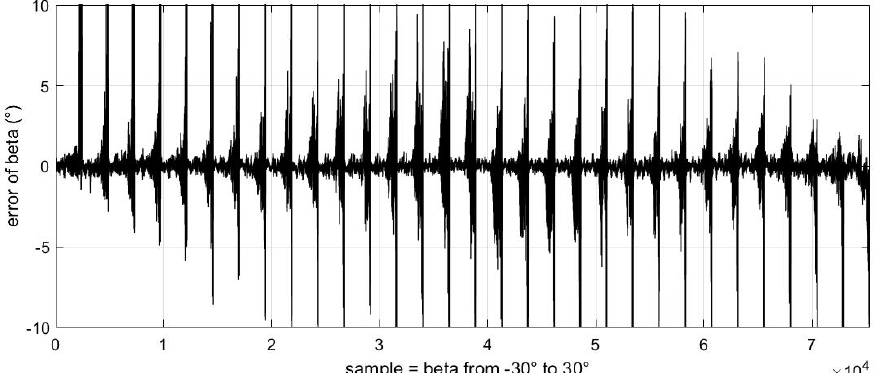
Figure 17. The relationship between angle of attack estimation error and sideslip angle value.